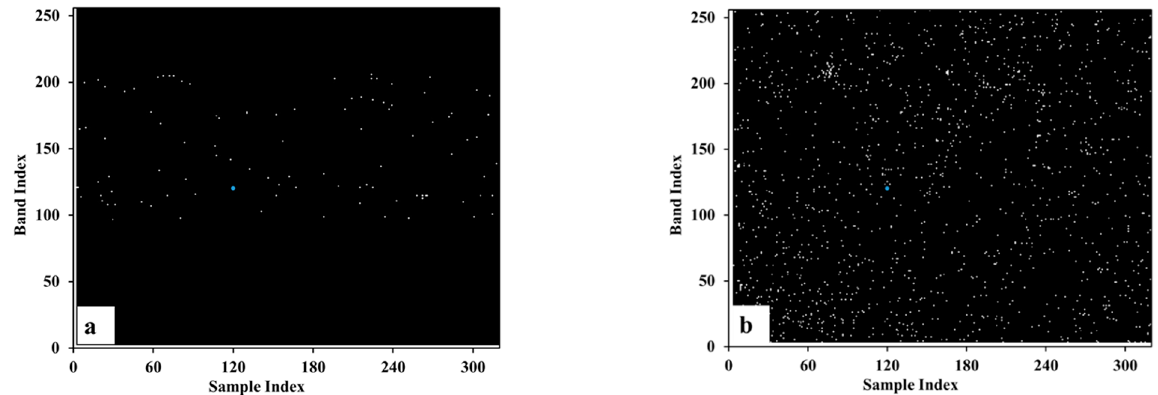
Figure 5. The extracted mask from on-board black body data using different methods. ( a ). GB/T 17444-2013; ( b ). our method.